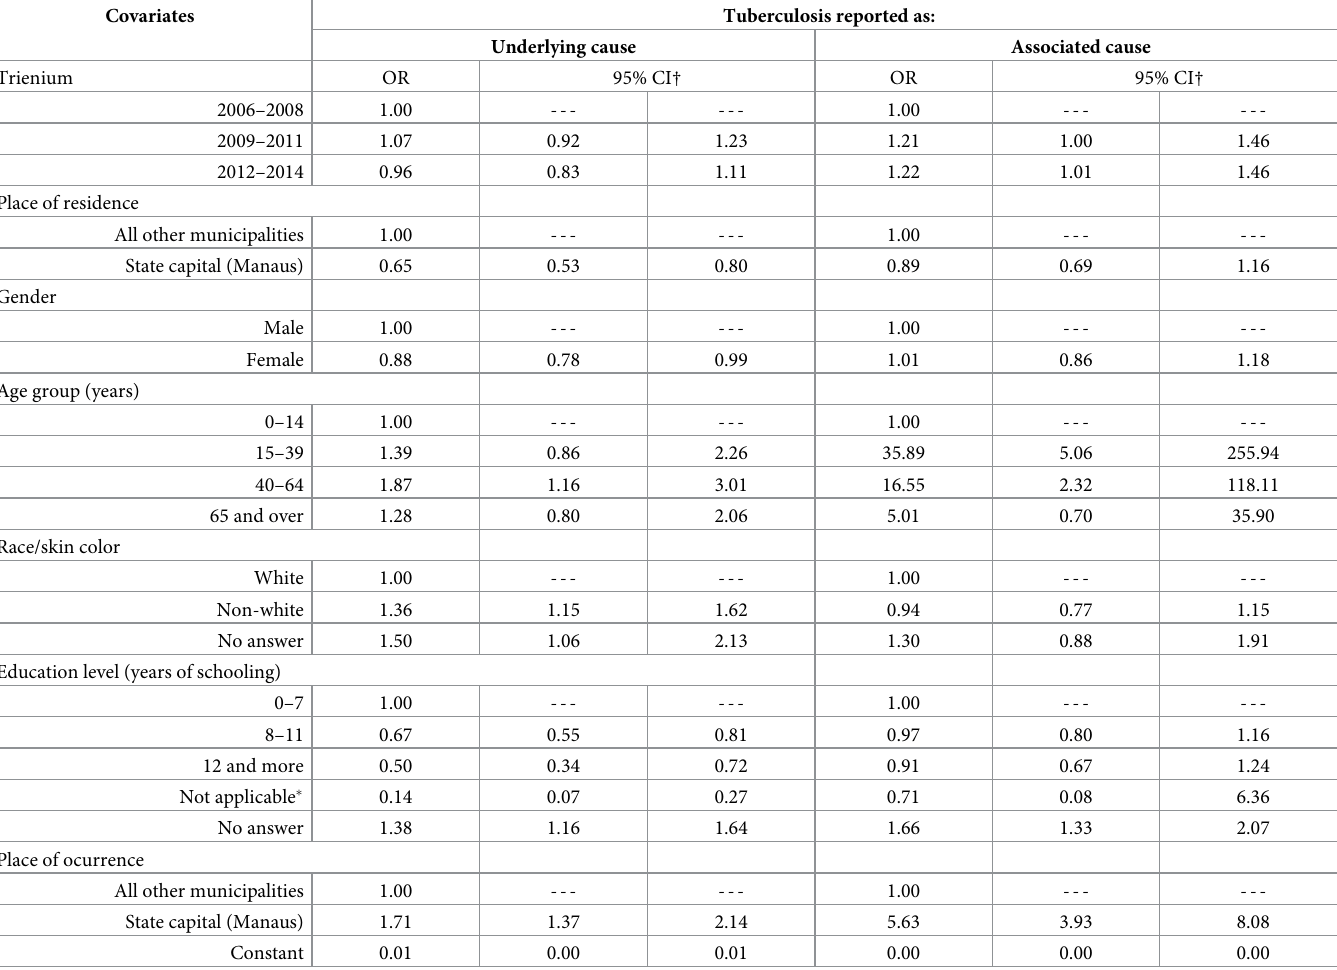
Table 3. Adjusted odds ratios for reporting tuberculosis § as an underlying and associated cause of death, State of Amazonas, Brazil, 2006 to 2014.